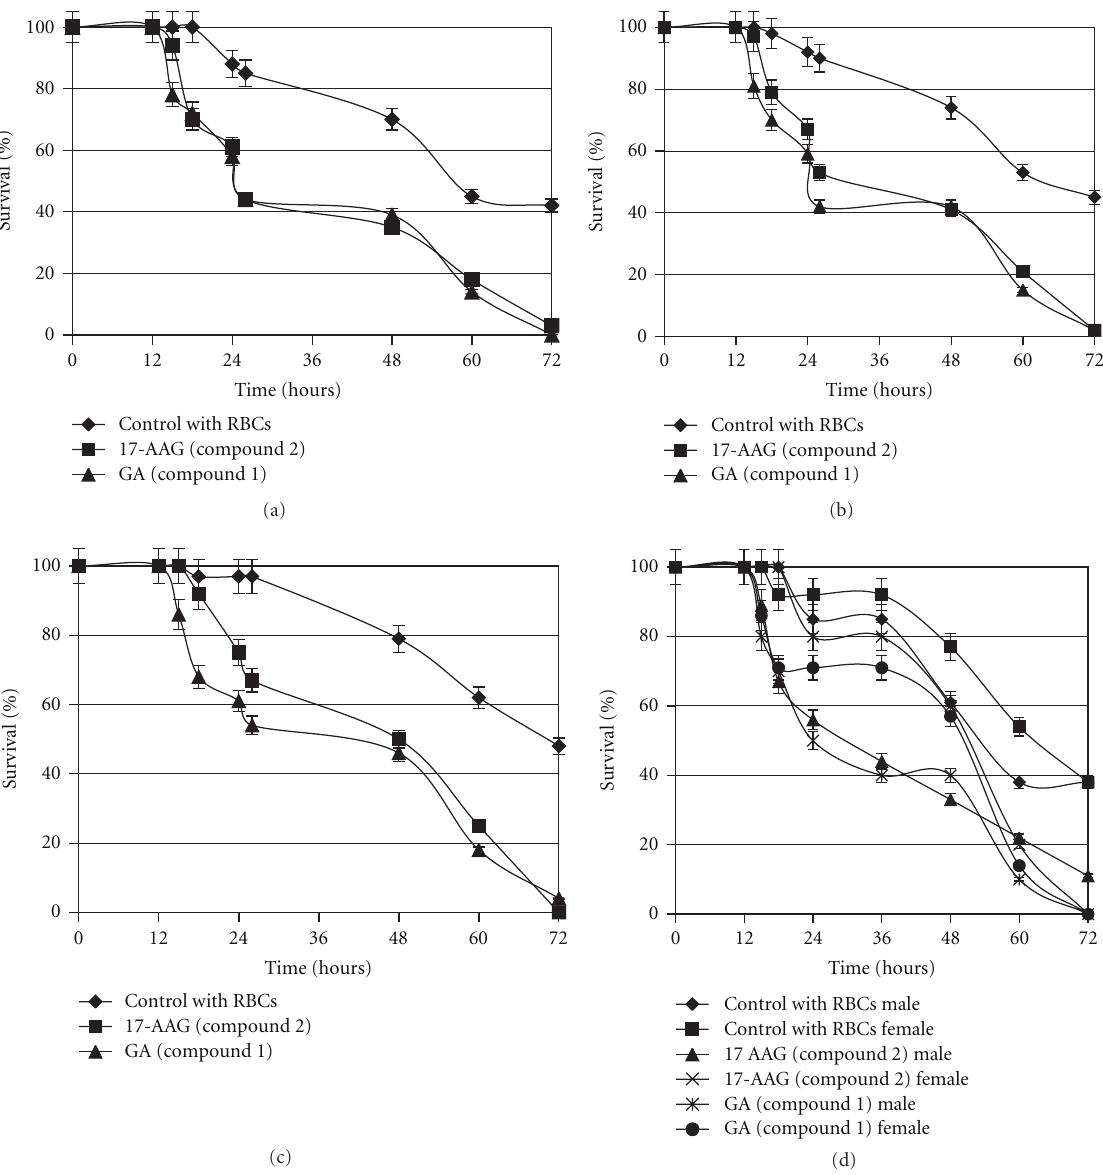
Figure 2: (a). Survival of paired adult male and female Schistosoma japonicum in the presence of human red blood cells and five micromolar geldanamycin (GA, triangles) or five micromolar 17-AAG (squares) compared to control parasites supplemented only with human red blood cells (diamonds). 50%–60% mortality was achieved at 24 hours while 90% of controls remained viable ( P < . 001). (b). Survival of individual male worms. 50%–60% mortality was achieved at 24 hours while 90% of controls remained viable ( P < . 001). (c). Survival of individual female worms. 35%–50% mortality at 24 hours while 95% of controls remained viable ( P < . 001). At 72 hours 17-AAG and GA caused 50% greater mortality versus controls. D. Survival of individual male and female worms cultured together. GA, male, star. GA female, circle. 17-AAG male, triangle. 17-AAG female, cross. At 36 hours GA caused 60% mortality in male worms while 90% of controls remained viable ( P < . 001). At 72 hours 90%–100% of GA and 17-AAG treated worms were dead versus 50% mortality in controls ( P < . 001). For (a)–(d), the data represent the mean ± S.D. of triplicate determinations in a representative